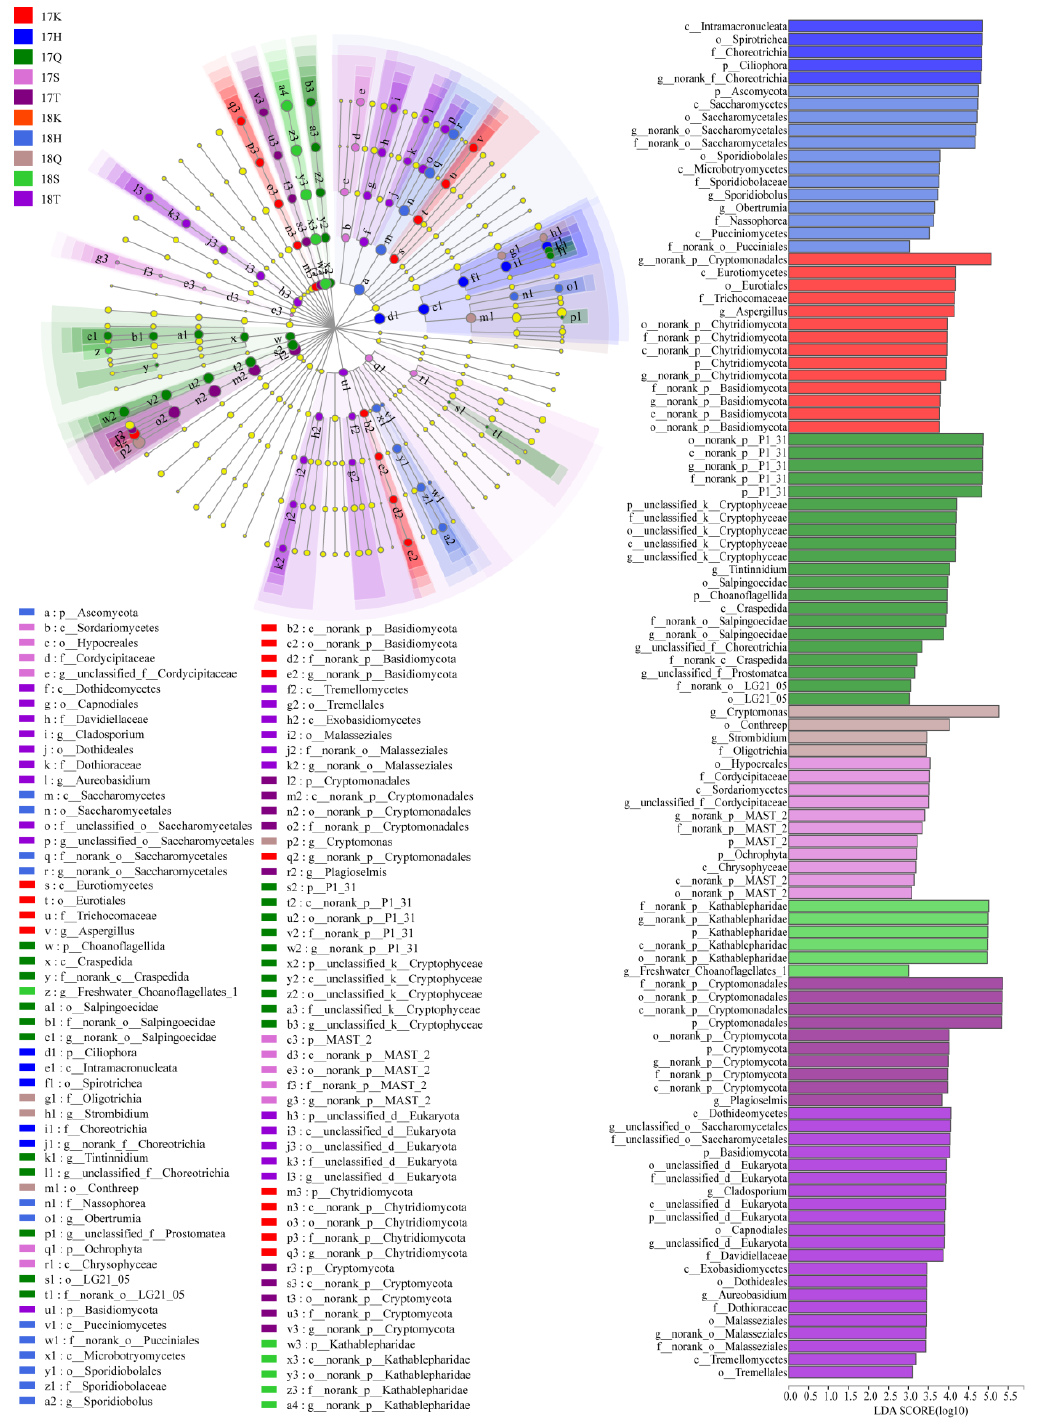
Figure 5. LEfSe multistage discriminant analysis of taxonomic di ff erences. In the figure on the left, the circular diagram represents the classification level, from phylum to genus, from the inside to the outside. The nodes in di ff erent colors represent the microbial groups that are enriched significantly in the corresponding group and have a significant influence on the di ff erence between the groups. The light yellow nodes represent the microbial groups that are not significantly di ff erent among di ff erent groups or have no significant influence on the di ff erence between groups. The LDA histogram shows the number of microbial groups that have significant e ff ects in multiple groups. The LDA scores were obtained through LDA. The larger the LDA score is, the greater the impact of the abundance of that taxon on the observed di ff erence.